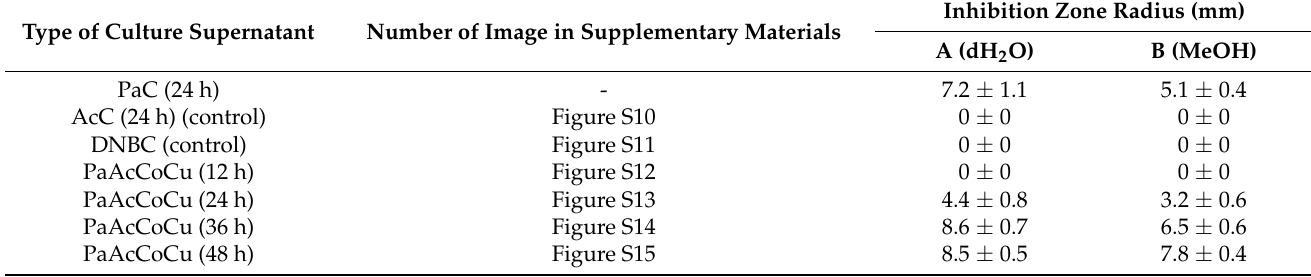
Table 5. Antimicrobial activity of different culture supernatants of P. apiarius SBUG 1947 against A. citreus